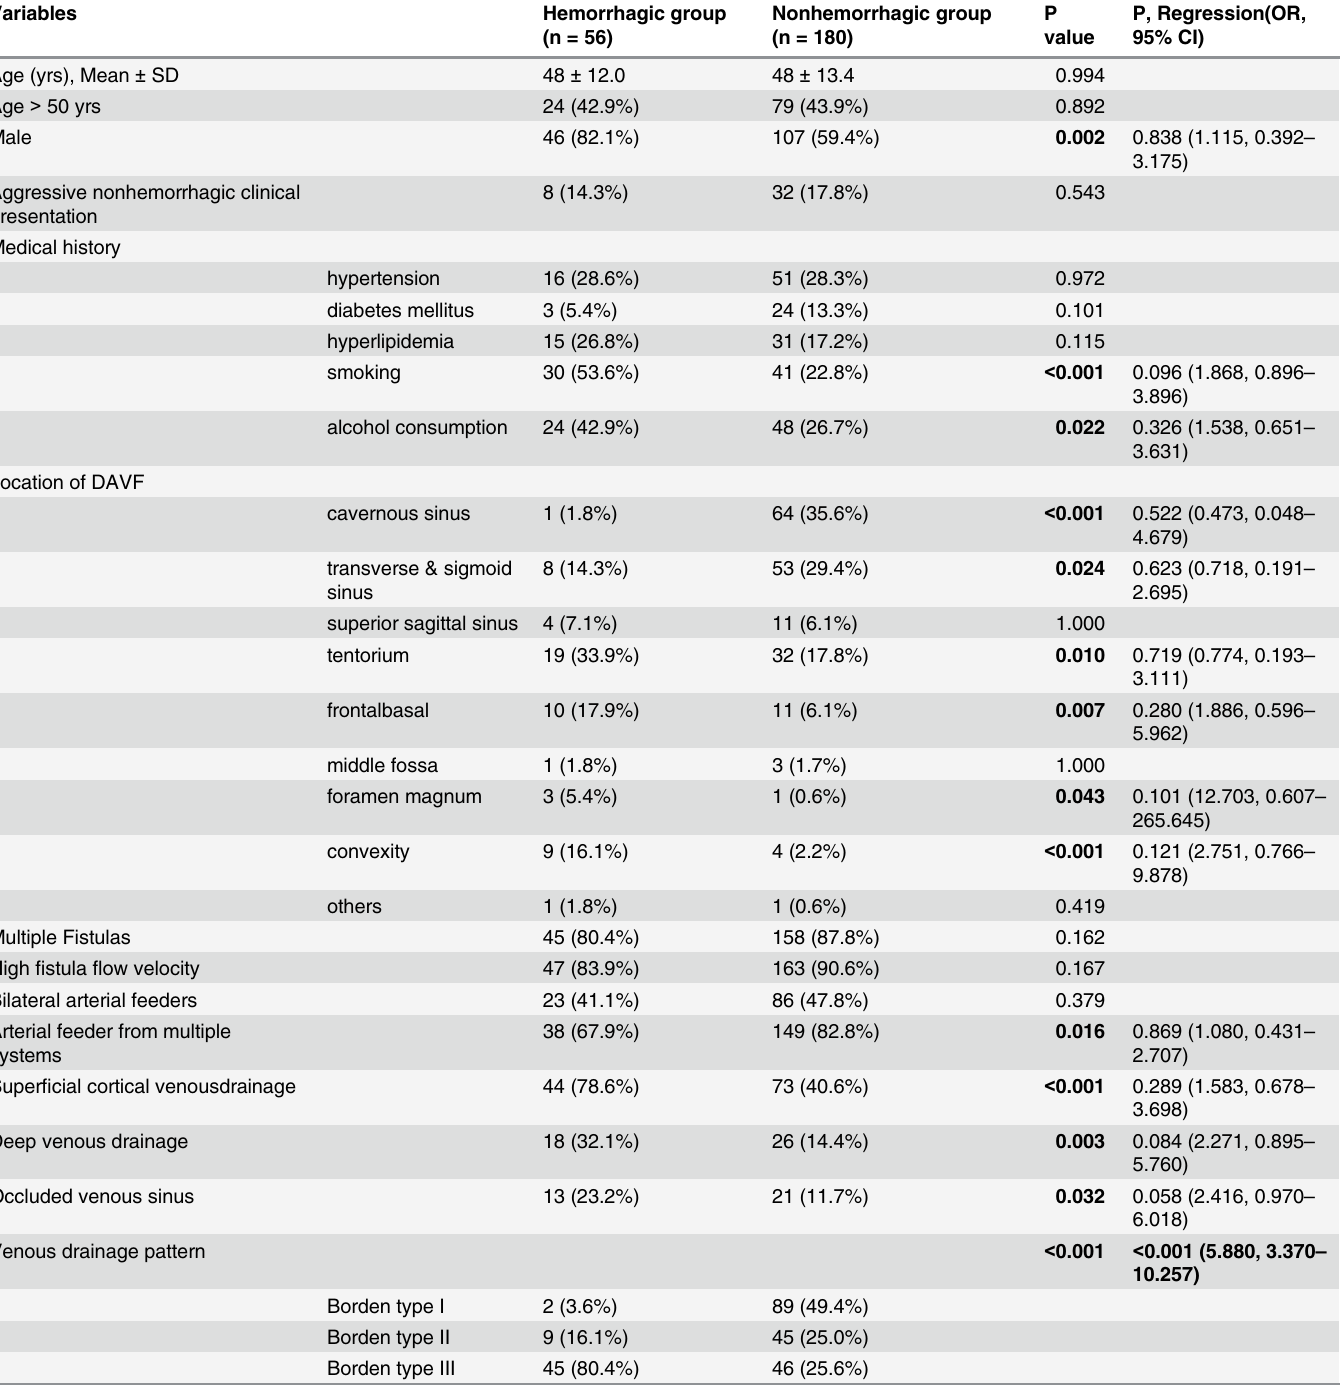
Table 3. Demographic, clinical and angiographic characteristics of patients with dural arteriovenous fistula in hemorrhagic and nonhemorrhagic groups.